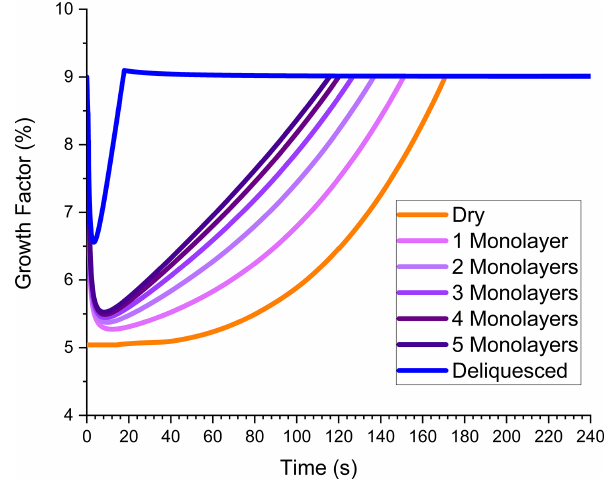
Figure 4. Growth factor vs. time in the flow tube for dry (no ALW) ammonium sulfate seed particles (orange), effloresced seed parti- cles initially containing 1–5 water monolayers on the surface (pur- ple shades), and deliquesced seed particles (blue). Condensation, partitioning, and dimer formation are all included. The ozone mix- ing ratio is